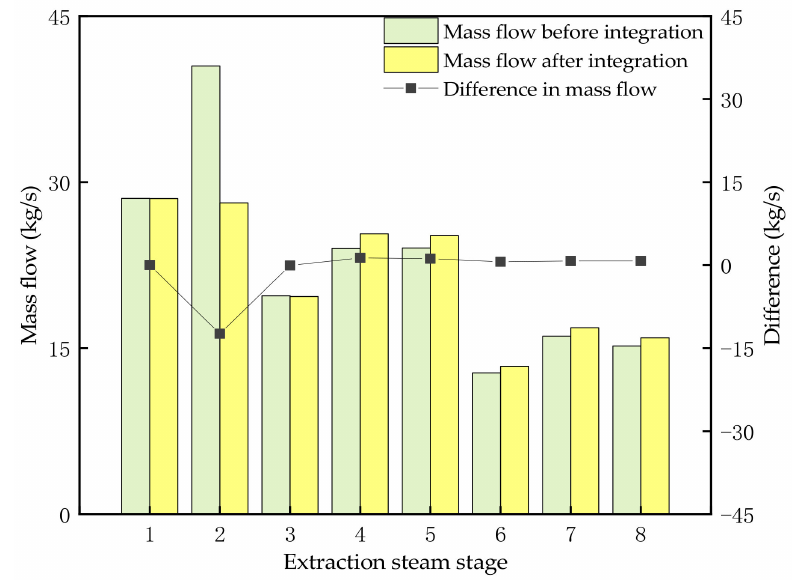
Figure 4. Variation in the mass flow of each extraction steam stage of CFPU before and after system